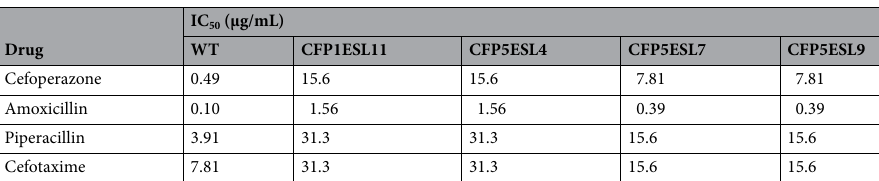
Table 2. IC 50 values of β-lactams for β-lactam-resistant strains. IC 50 values (µg mL −1 ) for the wild-type strain and the four cefoperazone-resistant clones (CFP1ESL11, CFP5ESL4, CFP5ESL7, and CFP5ESL9) are the means of three independent